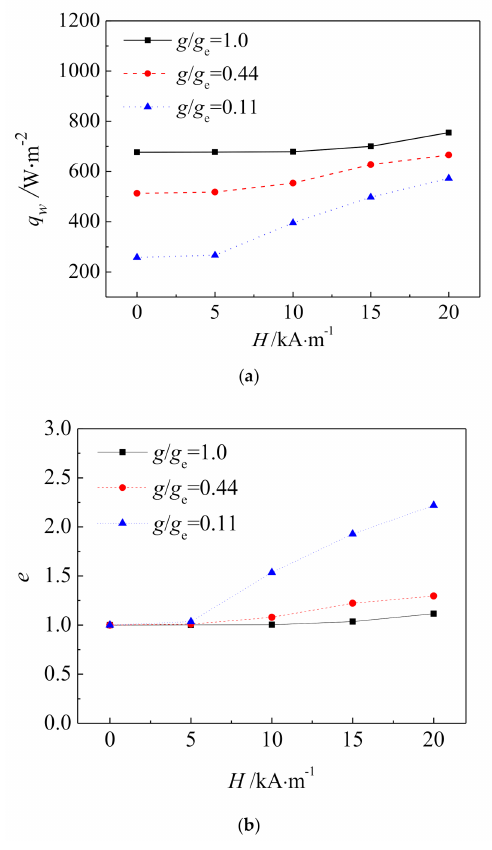
Figure 7. The variations of the ( a ) averaged heat flux and ( b ) heat flux enhancement ratio with magnetic field intensity H at different gravity levels under a uniform magnetic